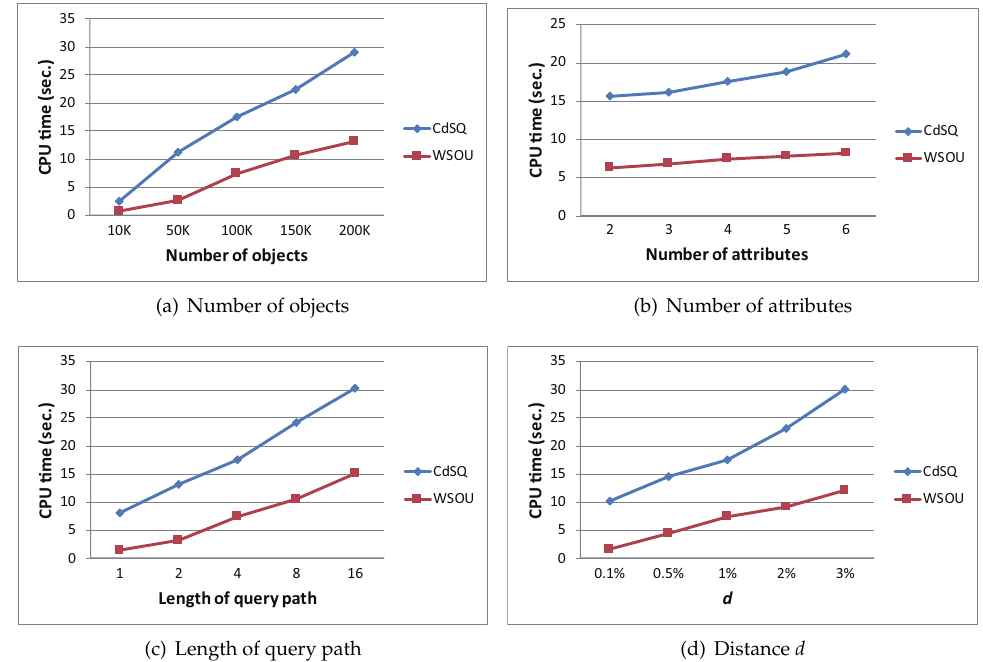
Figure 6. Effect of four important factors. WSOU, within skyline object